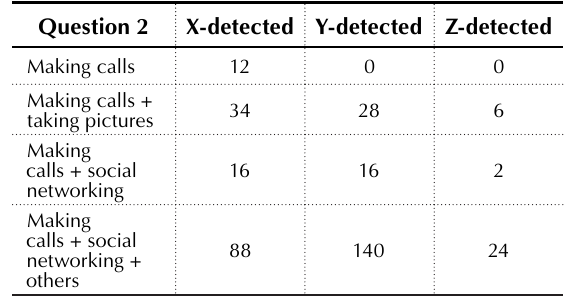
Table 3. The obtained data